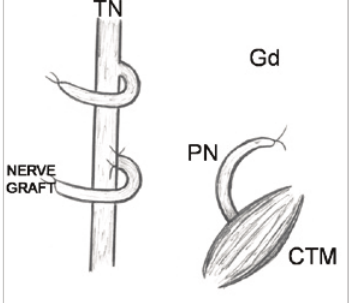
FIGURE 2 – Denervation control group (Gd). TN : tibial nerve. PN : peroneal nerve. CTM : cranial tibial muscle. Group 1 (G1) underwent the single-stage procedure.